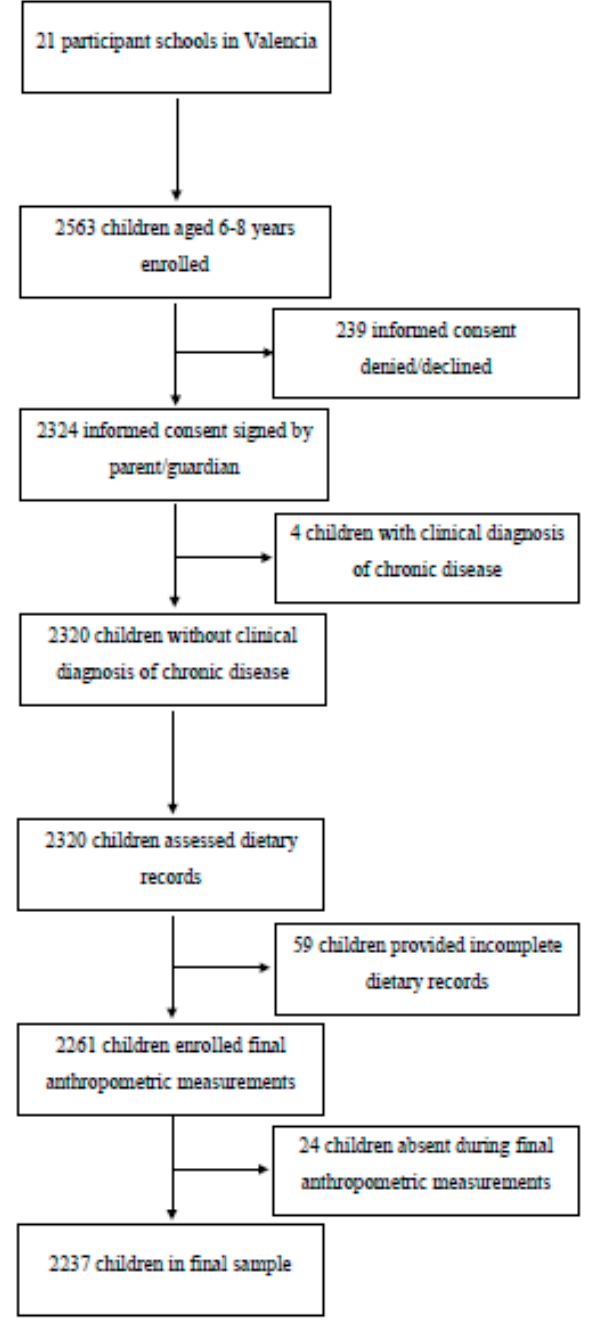
Figure 1. Recruitment of children for participation. 2.2. Anthropometric Measures